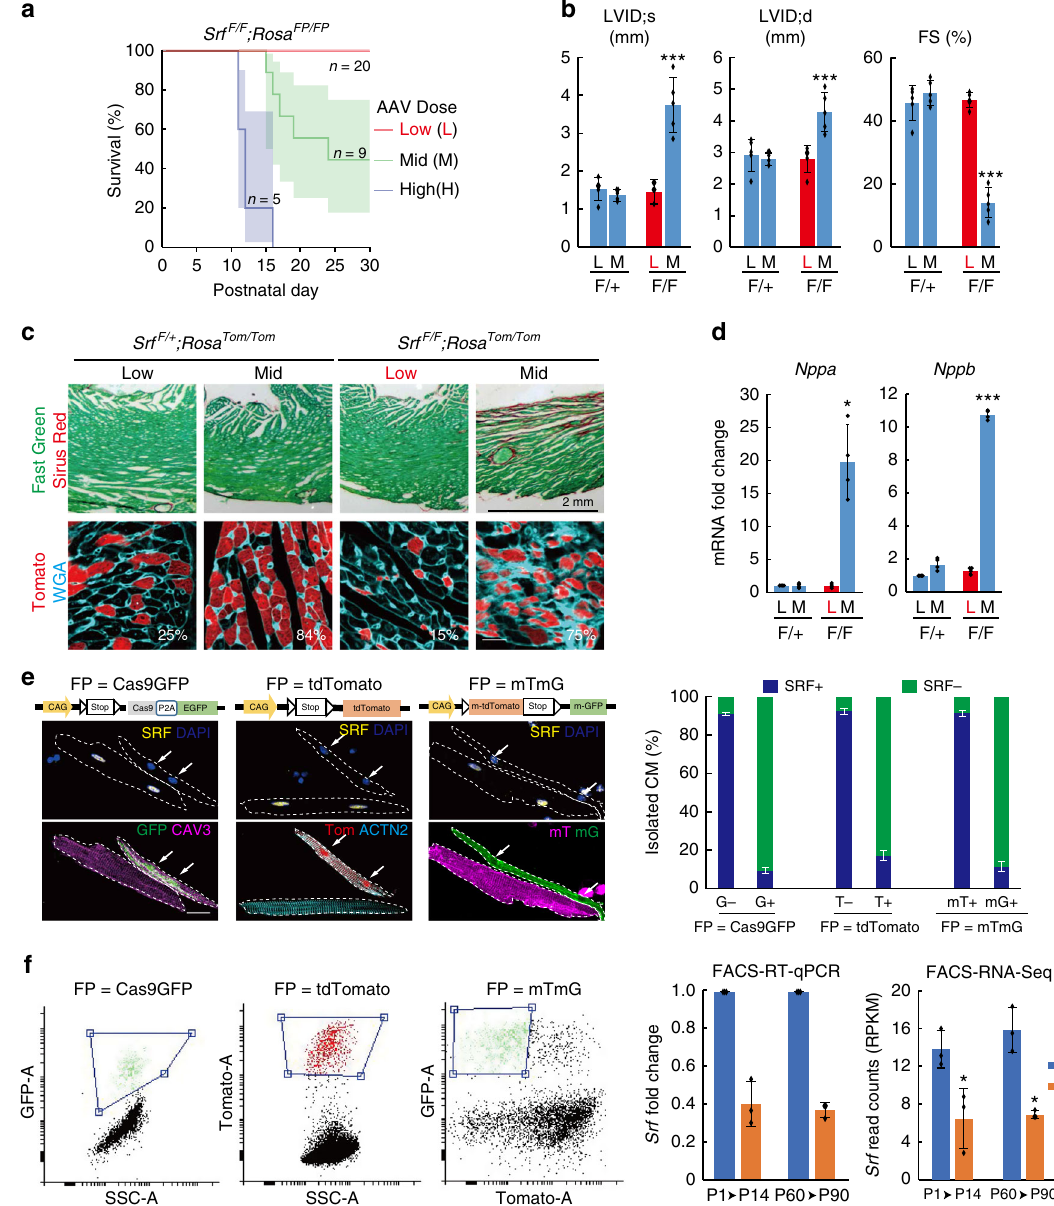
Fig. 1 Mosaic knockout of Srf circumvents disruption of global heart function. a Survival curve of Srf F/F ;Rosa FP/FP mice treated with low, mid, and high doses of AAV-Cre at P1. b Effect of AAV-Cre dosage on heart function and chamber size at P30. Left ventricle (LV) function and size were assessed echocardiographically by measuring the LV fractional shortening (FS) and internal diameter at end systole (LVID;s) and diastole (LVID;d). n = 5 per group. c Effect of AAV-Cre doses on myocardial fi brosis. Fibrosis was measured from heart sections stained with sirus red (top) or wheat germ agglutinin (WGA, bottom). The fraction of FP + cells in heart sections was quanti fi ed and labeled in white. d RT-qPCR analysis of cardiac stress marker expression from heart ventricles. n = 4 per group. e Representative images of SRF immuno fl uorescence in FP + and FP − Srf F/F ;Rosa FP/FP CMs that were isolated from the same heart. Arrows point to SRF-FP + nuclei. Quanti fi cation was shown to the right. n = 3 hearts. f Representative FACS plots and gating to sort FP + CMs (left) and measurement of Srf expression in FACS-sorted FP + CMs (right) by RT-qPCR and RNA-seq. AAV-Cre was injected at P1 and CMs analyzed at P14, or AAV-Cre was injected at P60 and CMs analyzed at P90. n = 3 hearts. Bar plots show mean ± SD and are overlaid by dot plots of individual data. Two-tailed Student ’ s t test: * P < 0.05, *** P < 0.001. F/ + : Srf F/ + . F/F, Srf F/F . Scale bar, 20 µ